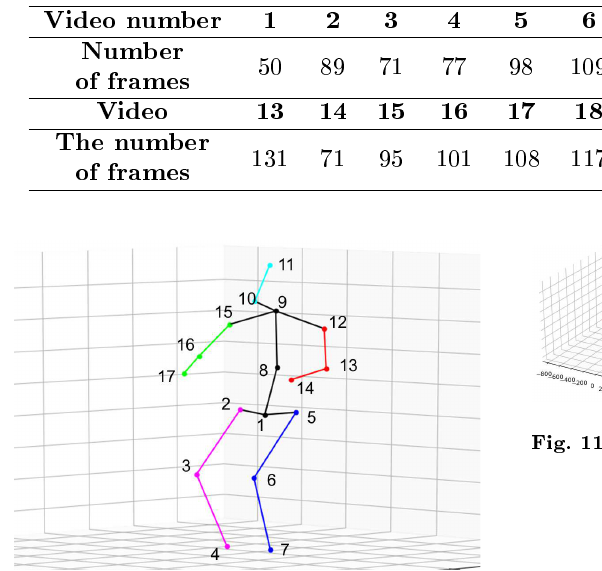
Fig. 10: The output of 3-D human pose estimation based on the method of Tome et al. [37]